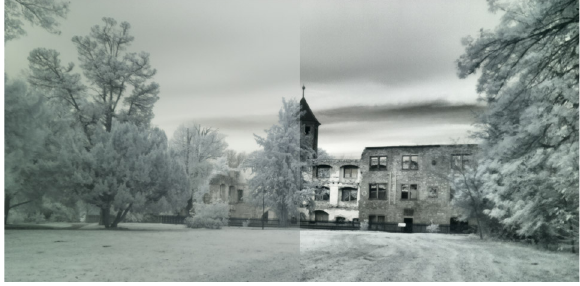
Figure 5: Histogram equalization applying the